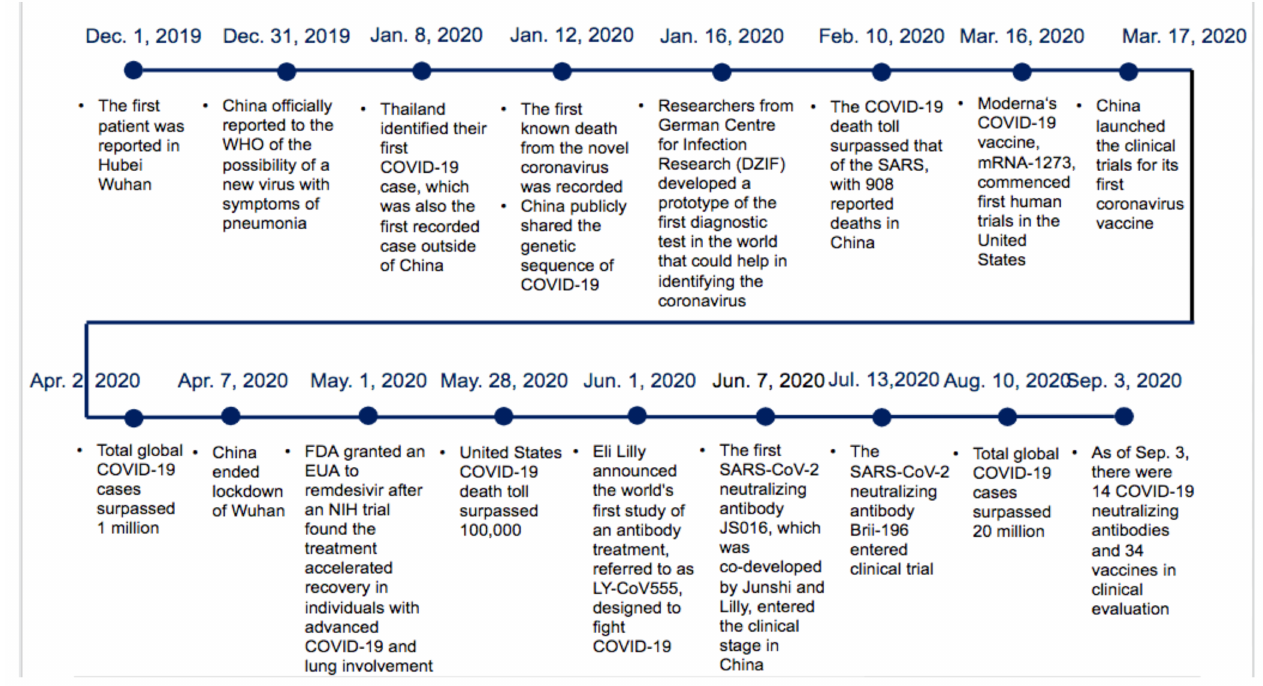
Figure 2. Timeline of the COVID-19 situation in China. (Adapted from source: NHSA data